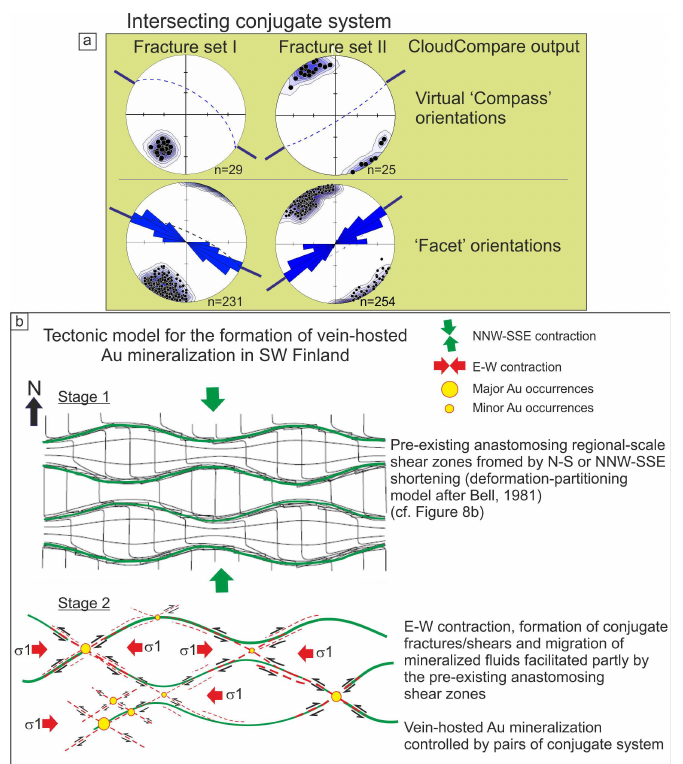
Figure 9. ( a ) Orientation data for fracture sets I and II. Virtual outcrop analysis allows for interpretation of fracture sets I and II as a conjugate pair. ( b ) Tectonic model showing pre-existing anastomosing shear zones formed syn- or pre-D4 (NNW-SSE contraction), which were later reactivated with the formation of new conjugate shears during E-W tectonic shortening (D5). Intersecting areas could be potential sites of gold occurrences as seen in the case of Jokisivu gold mine, Satulinmäki and other gold